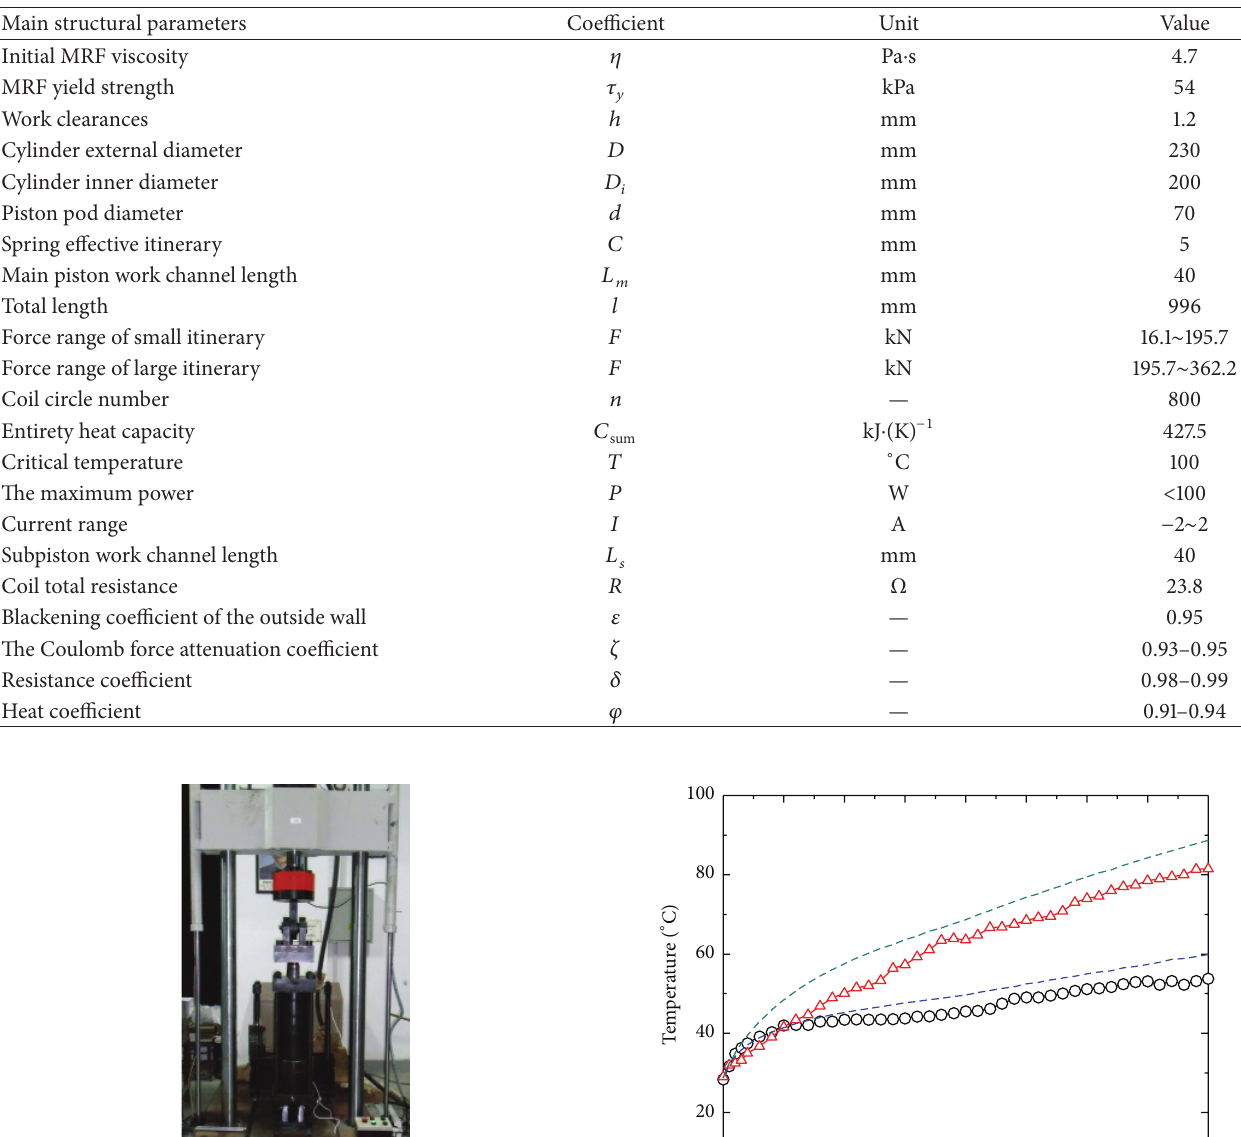
Table 2: Main structural parameters of the SDMR damper.